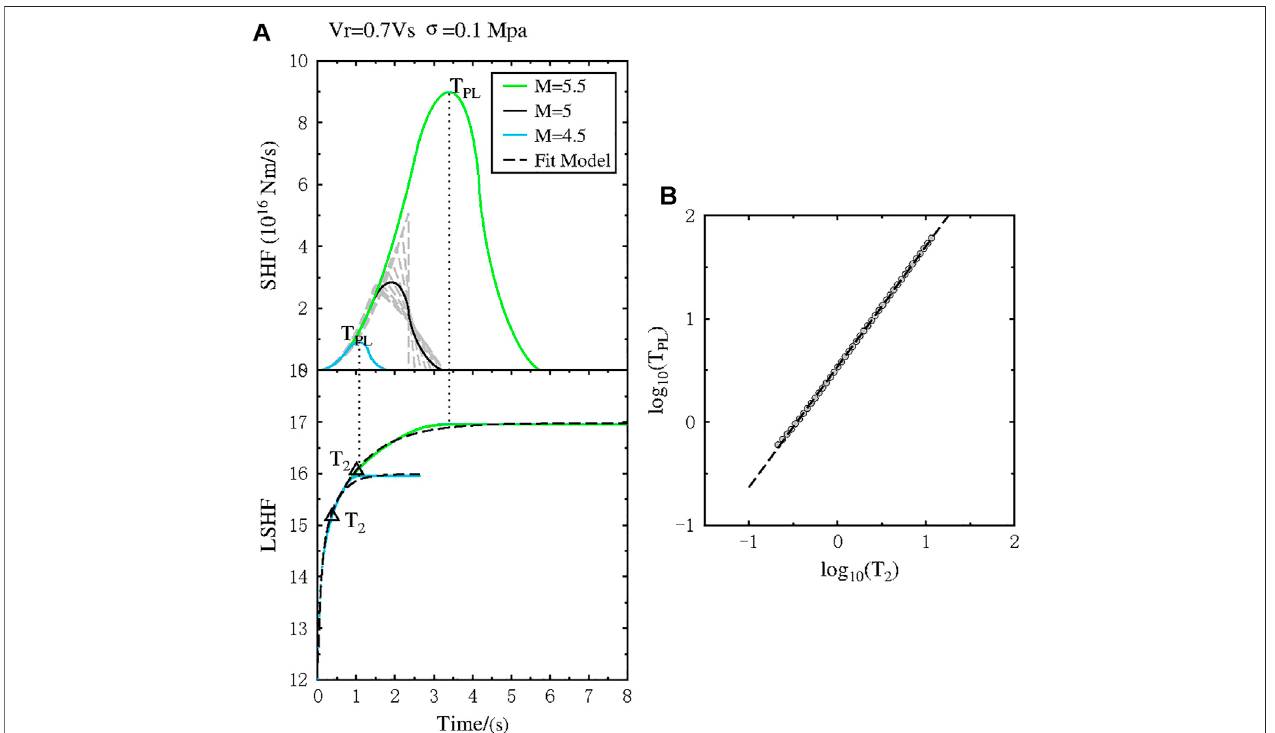
FIGURE8| Theexploratorysimulationsfor Δσ (cid:2) 0.1 MPa. (A) FittingoftheSato&Hirasawafunctionwithexponentialmodel.TheSHFandLSHFstandfortheSato & Hirasawa moment rate Function (SHF) and the log of the SHF (LSHF), respectively. The grey hatched curves display different SHFs, obtained by changing the polar angleoftheobservationpointfrom0 o to90 o .TheblacksolidlineshowstheaverageSHFfor M (cid:2) 5event.TheblueandgreenlinerepresenttheaveragedSHFfor M (cid:2) 4.5 and M (cid:2) 5.5 event, respectively. The dashed line represents the fi tted model. (B) Relationship between T 2 and T PL for magnitude from 4 to 8 with an interval of 0.1 magnitude units. The dashed line shows the fi tting relationship between T 2 and T PL